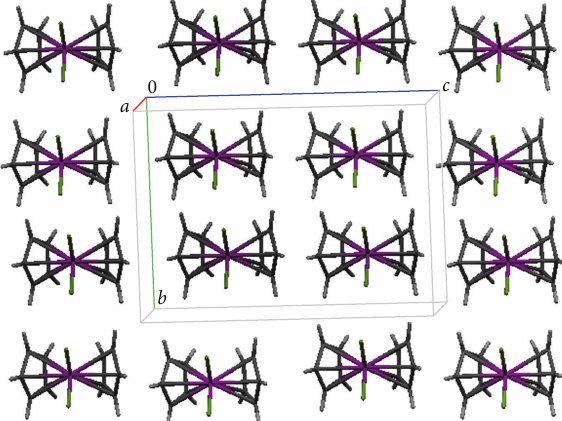
Figure 2: Drawing of the crystalline packing of complex 1